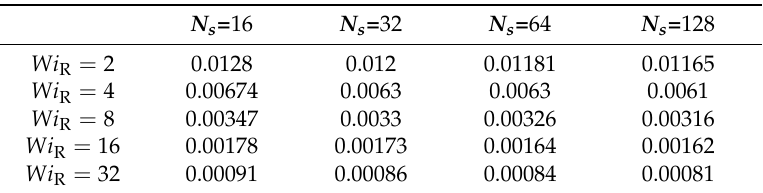
Table A2. Values of P 2 corresponding to the upper limit of ∆ t / ζ s in the slip-spring simulations for 2 various chain lengths and Rouse Weissenberg numbers.